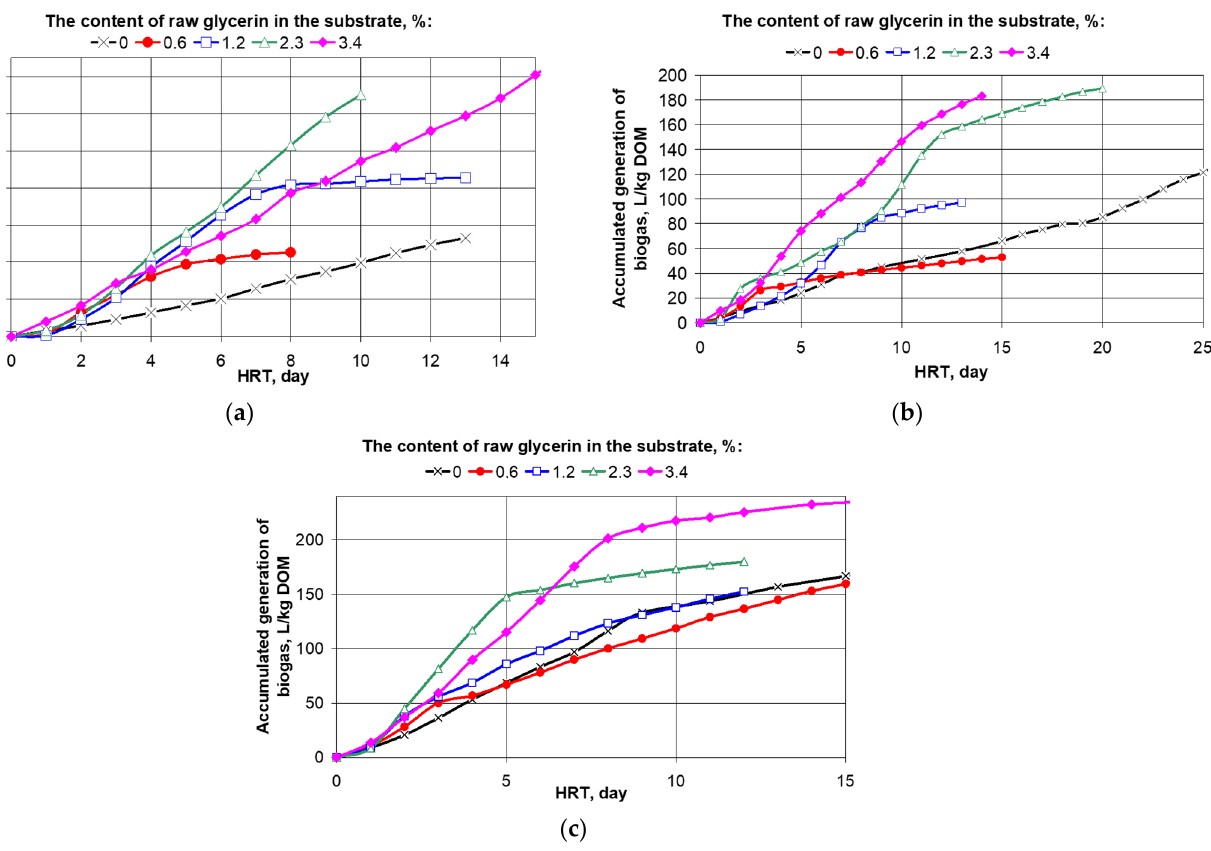
Figure 3. Accumulated biogas yield of cattle manure fermentation with the addition of crude glycerine at the fermentation temperature: ( a ) 30 ◦ C, ( b ) 35 ◦ C, and ( c ) 40 ◦